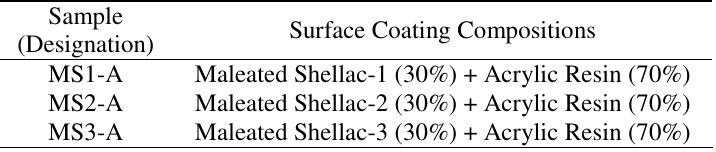
Table 2. Designation and coating composition of